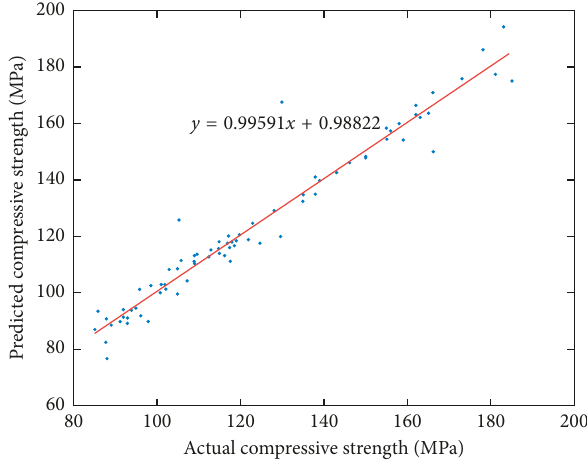
Figure 7: Performance of the prediction.